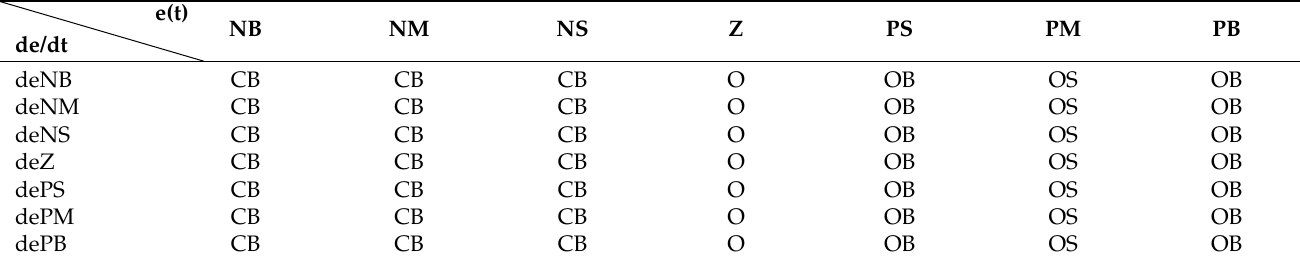
Table 2. Inference rule bases for FLC.